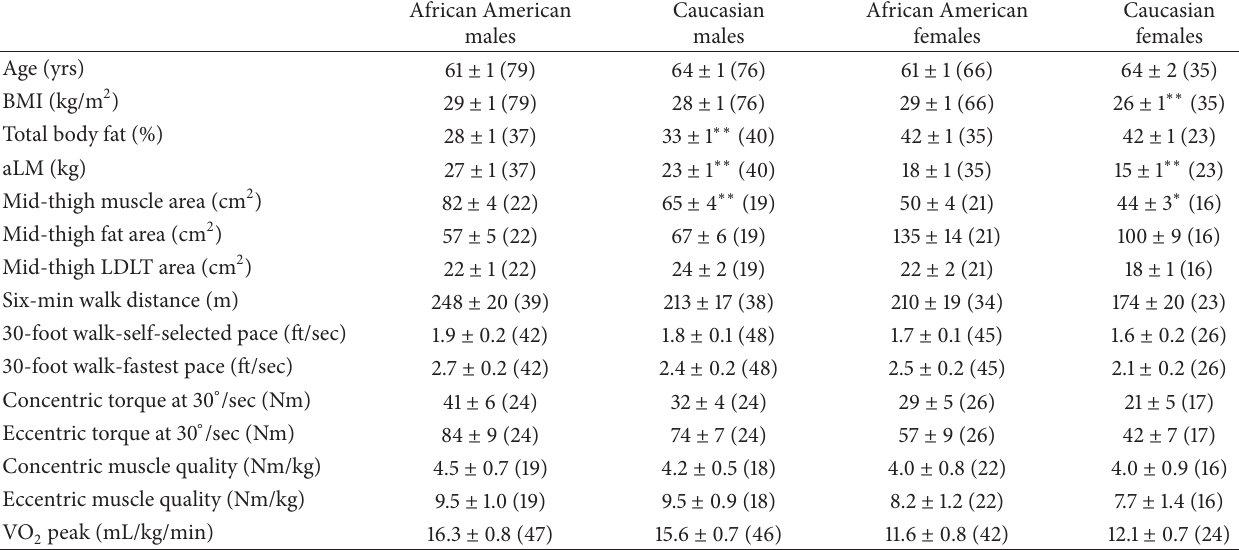
Table 1: Demographic, strength, and functional data in chronic stroke